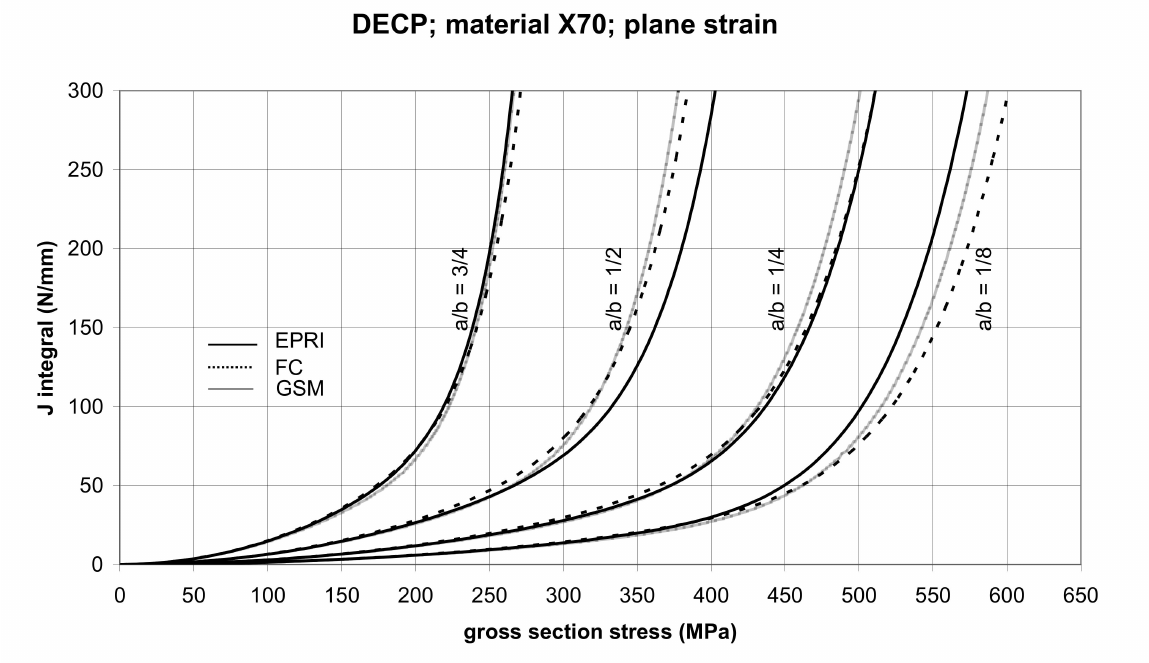
Figure 13. Comparison of J integral for DECP X70 steel specimens in the plane strain condition as determined by the EPRI, GSM, and FC